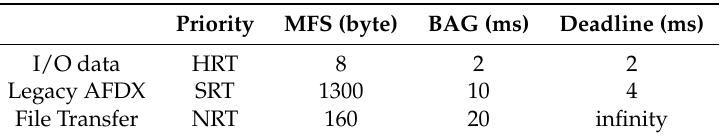
Table 3. Traffic